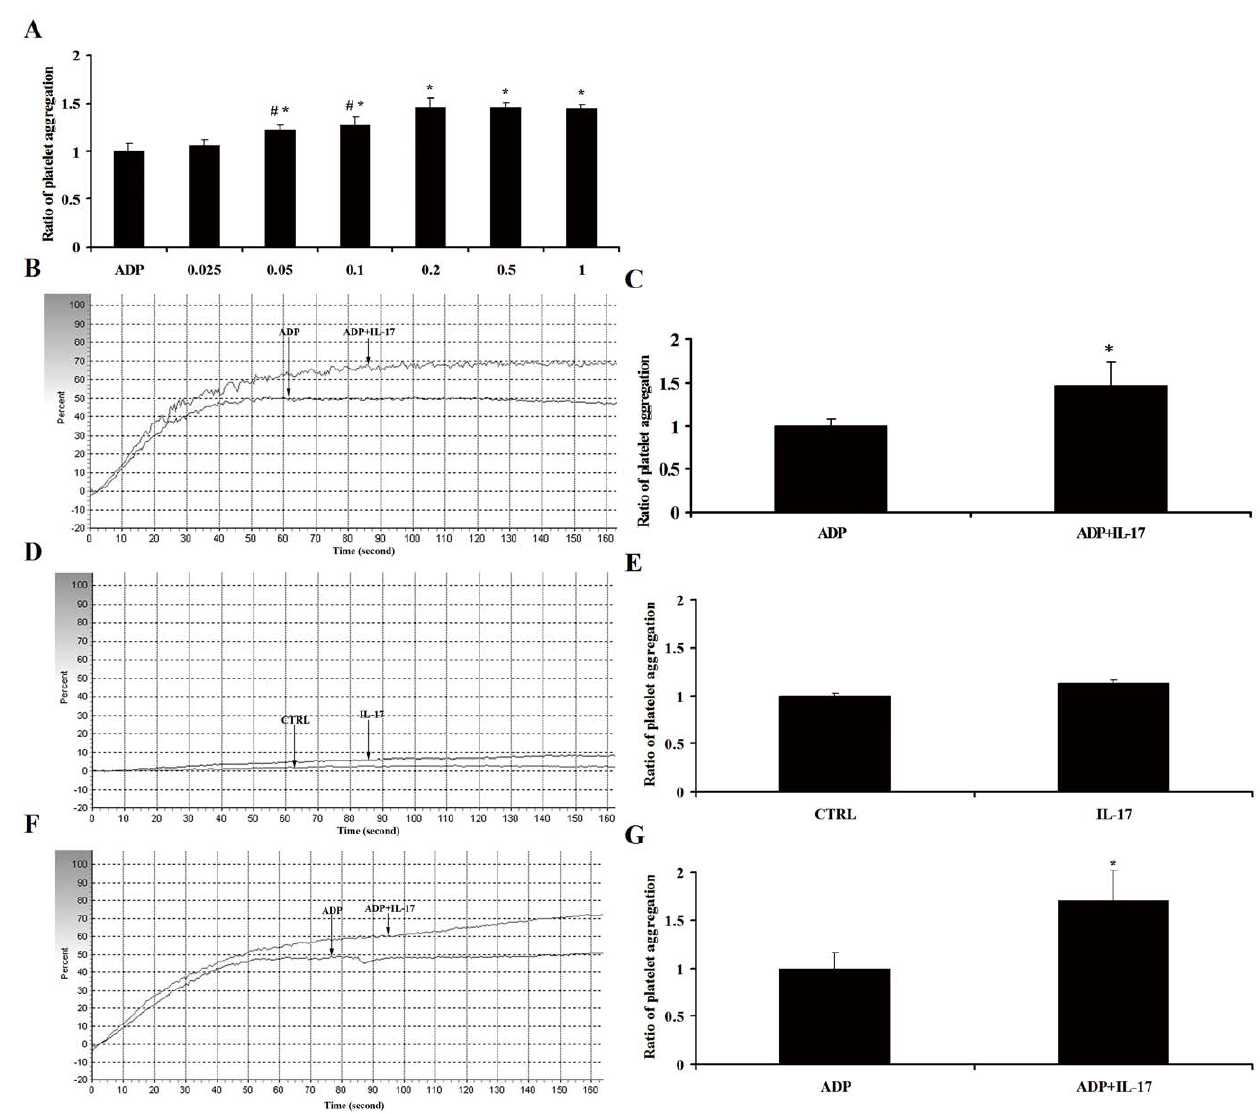
Figure 2. The effect of IL-17A on the platelet aggregation. (A) Platelet aggregation induced by ADP (3 m M) or ADP combined with IL-17A at 0.025, 0.05, 0.1, 0.2, 0.5 and 1 m g/ml. (B) Representative pictures for the platelet aggregation induced by ADP or ADP + IL-17A in ACS patients. (C) The results of statistical analysis for ratio of the platelet aggregation induced by ADP or ADP + IL-17A in ACS patients. (D) Representative pictures for platelet aggregation induced by IL-17A alone or CTRL (without any intervention) in ACS patients. (E) The results of statistical analysis for the ratio of platelet aggregation induced by IL-17A alone or CTRL (without any intervention) in ACS patients. (F) Representative pictures for the platelet aggregation induced by ADP or ADP + IL-17A in healthy subjects. (G) The results of statistical analysis for ratio of the platelet aggregation induced by ADP or ADP + IL-17A in healthy subjects. *, p , 0.05 vs ADP group, # , p , 0.05 vs 0.2 m g/ml group. Values are means 6 SEM of five independent experiments with different donor